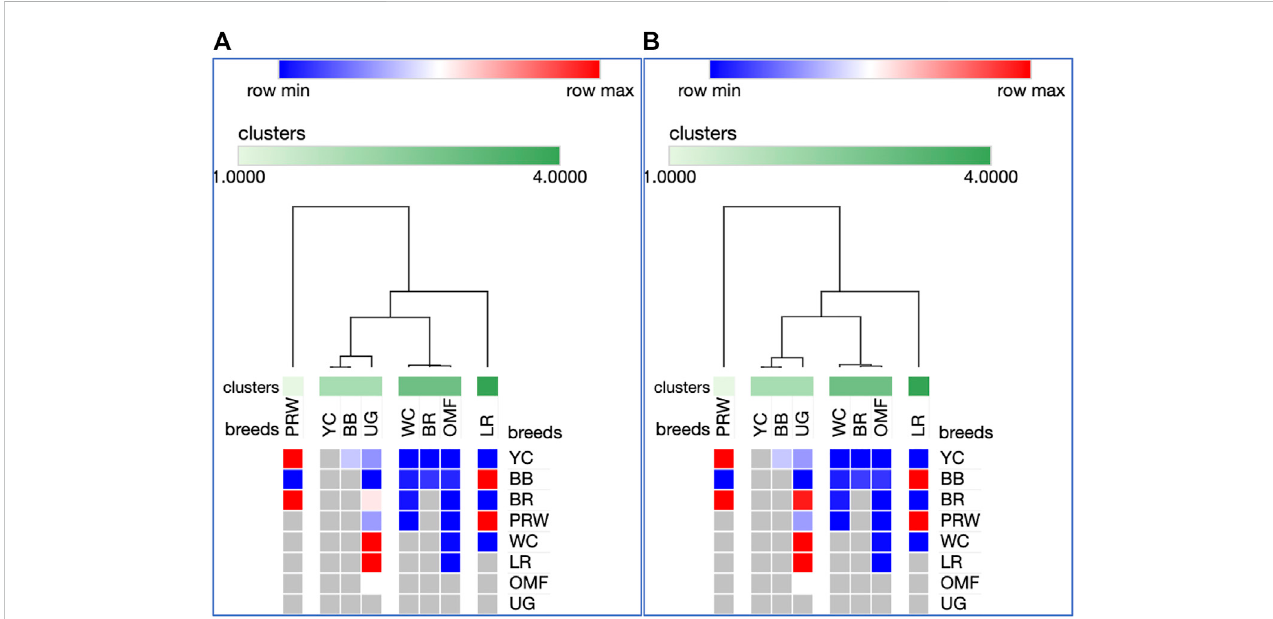
FIGURE 4 Heatmaps and hierarchical clustering trees based on Euclidean distance metric (with the average option selected for the linkage method) and using the Type IIIa (A) and IIIb (B) data as inferred for the eight studied breeds and seven tested myogenesis associated genes expressed in the breast